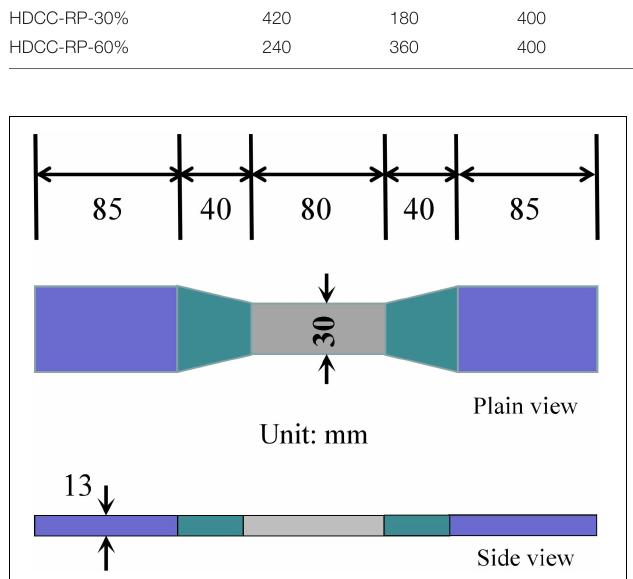
FIGURE 3 | Dimensions of dumbbell specimens.